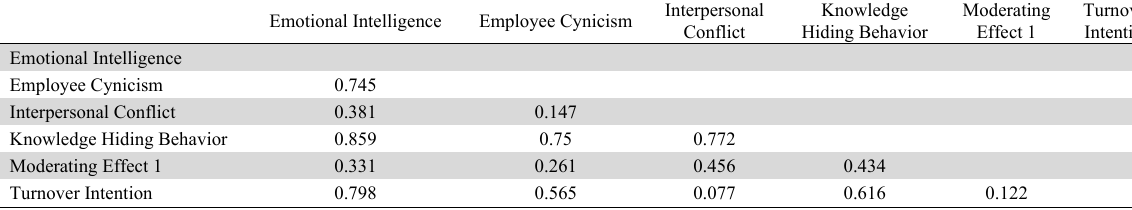
HTMT values, showing the discriminant